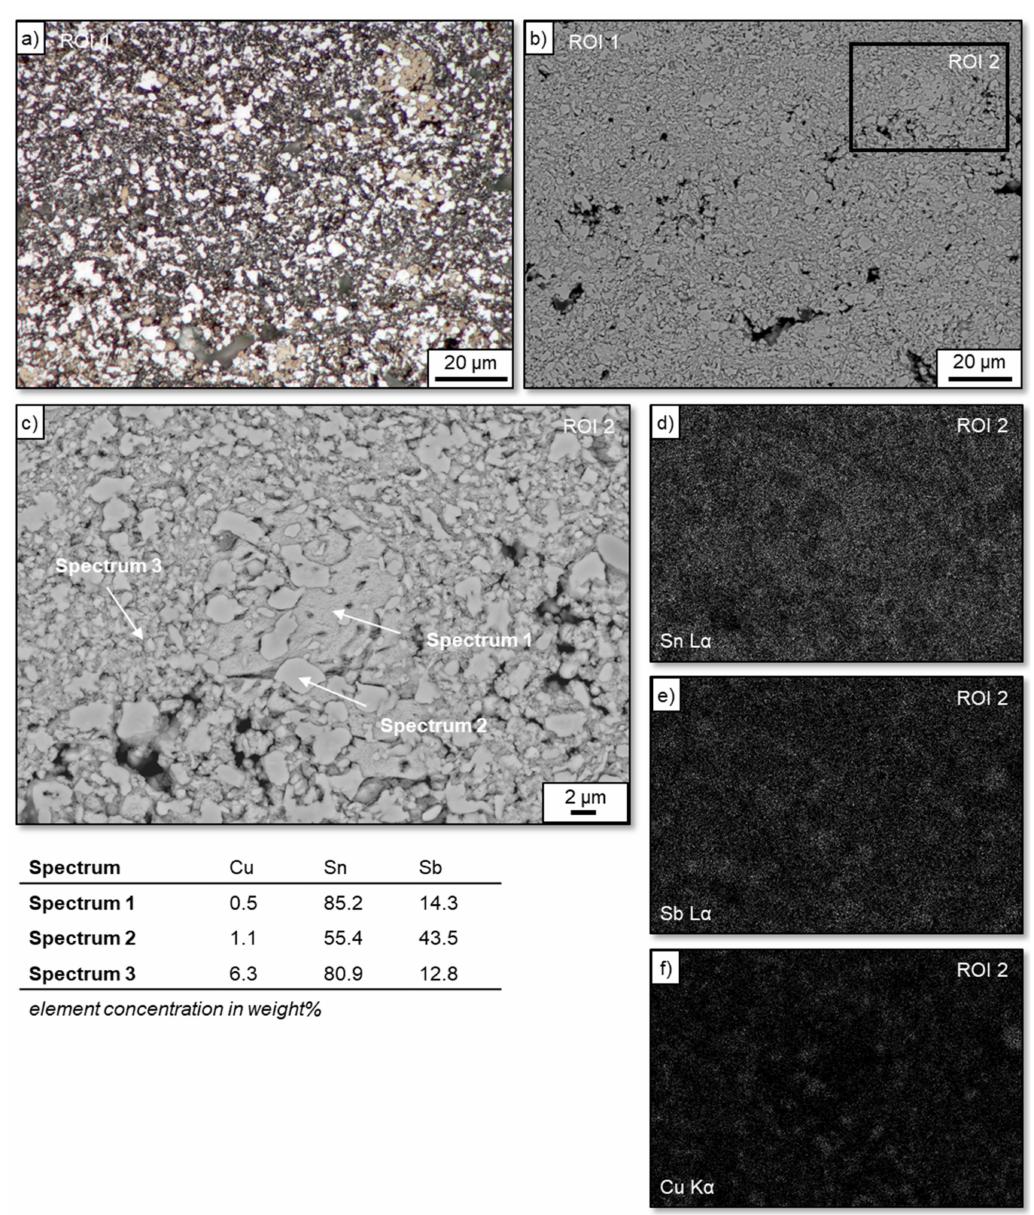
Figure 4. ( a ) Cross-section images taken by light microscopy and FE-SEM showing coating microstructure as obtained from the deposit using a PGT of 350 ◦ C and an ST of 20 ◦ C: ( a ) light micrograph of the ROI 1 after etching; ( b ) BSE imaging of the ROI 1; ( c ) BSE imaging at a magnified view (ROI 2); ( d – f ) corresponding EDS maps obtained from Sn L α , Sb L α and Cu K α at the ROI